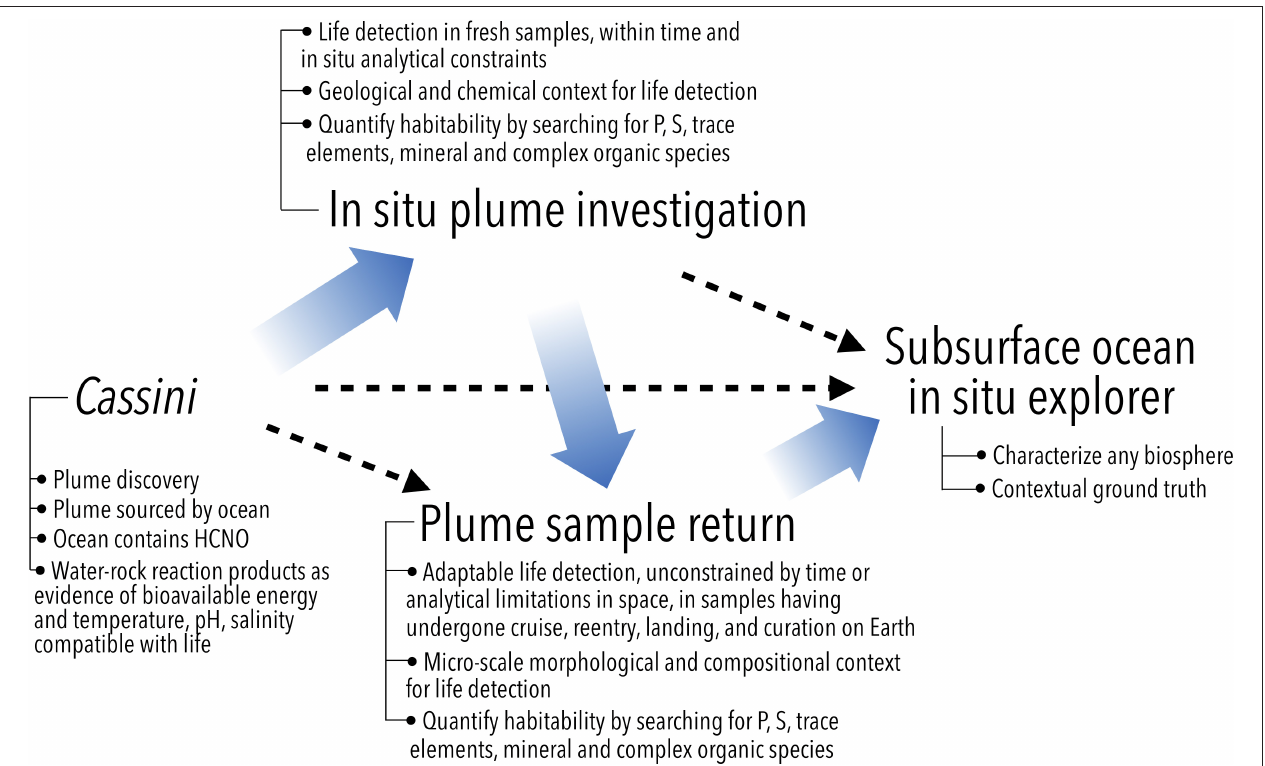
FIGURE 3 | Possible follow-on missions to Cassini to search for and investigate Enceladus’ potential biosphere (independent of specific architectures such as orbiter or lander). The need for geological and chemical context for life detection suggests an in situ plume investigation as a logical next step. The limitations in analytical capabilities for life detection can be overcome by a sample return mission, which can also benefit from a prior in situ study of plume material that establishes the baseline from which any alterations due to sample return can be identified. A far-future, direct investigation of the ocean would characterize any previously detected biosphere, or search for it at lower limits of detection. Steps in this logical path (wide arrows) may be bypassed (dashed arrows) depending on the evolving state of knowledge and the specific design and findings of future missions. Modified from Sherwood